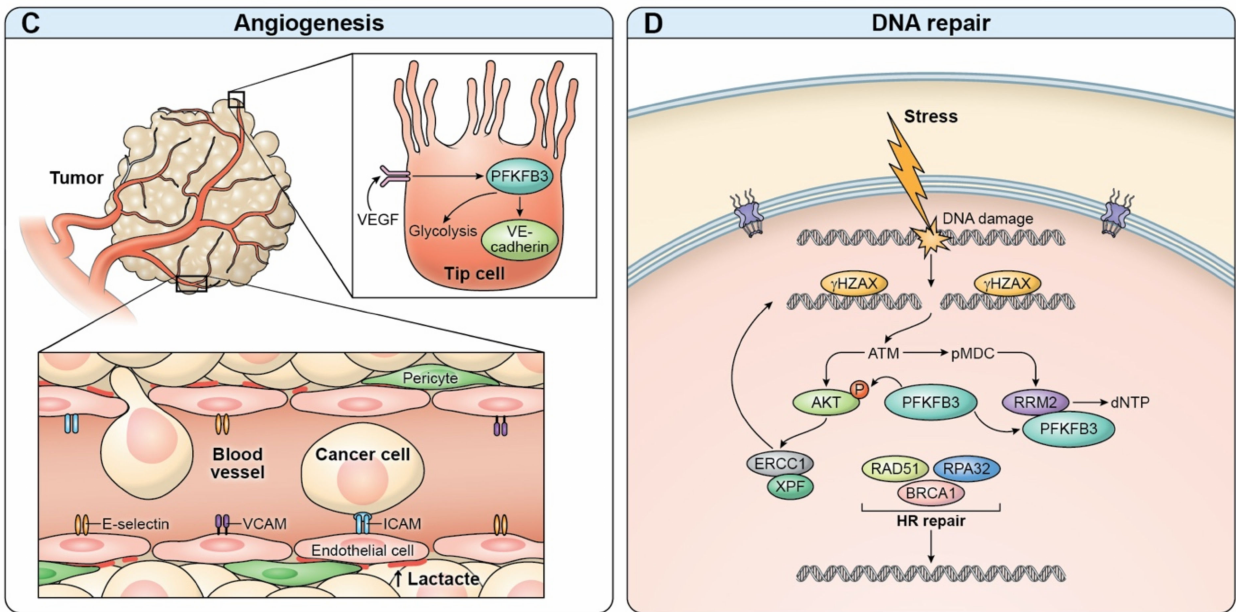
Figure 1. Metabolic and extra-metabolic functions of PFKFB3. The metabolic functions of PFKFB3 include driving aerobic glycolysis while also stimulating the pentose phosphate pathway ( A ). Extra-metabolic functions of PFKFB3 include cell cycle regulation ( B ), angiogenesis ( C ), and DNA repair after insult ( D ). Artist: Ethan Tyler, Medical Arts, Office of Research Services, National Institutes of Health, Bethesda, MD,